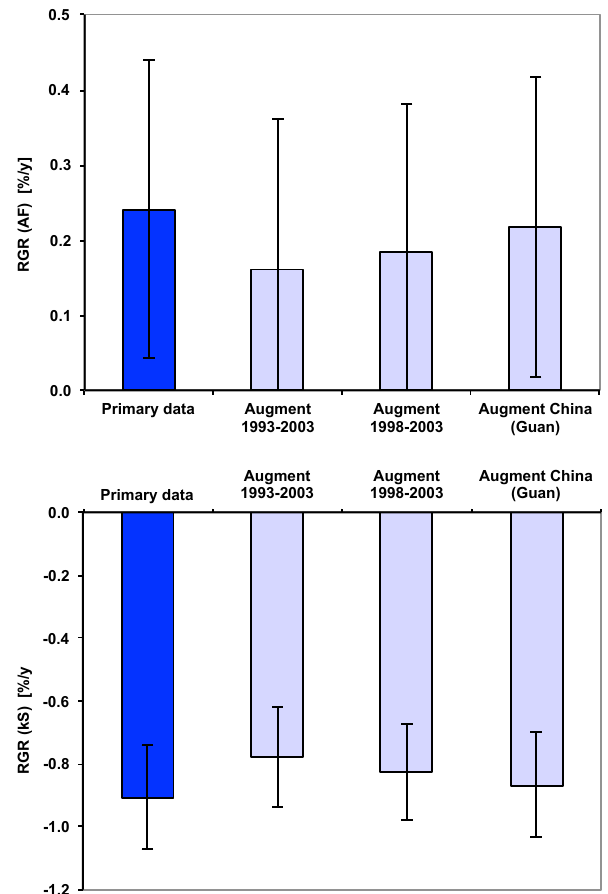
Figure D2. Estimates of RGR ( AF ) (upper panel) and RGR (k S ) (lower panel), using primary data for f Foss (blue bars, as in Fig. 2) and three alternative f Foss trajectories shown in Fig. D1 (pale grey Figure D2 (source: aaTrendEstimation.Results.V34.xls) bars). Trends are estimated using Eq. (A2). All estimates are com- puted using data treatment ( m , s , n ) and the combined trend detec- tion method, as for best estimates (Fig. 2 and Tables 1 and 2). Error bars show ± 1 σ confidence intervals. For RGR ( AF ) , all P values (probability of positive trend) exceed 0.69; for RGR (k S ) , all P val- ues (probability of negative trend) exceed 0.996.